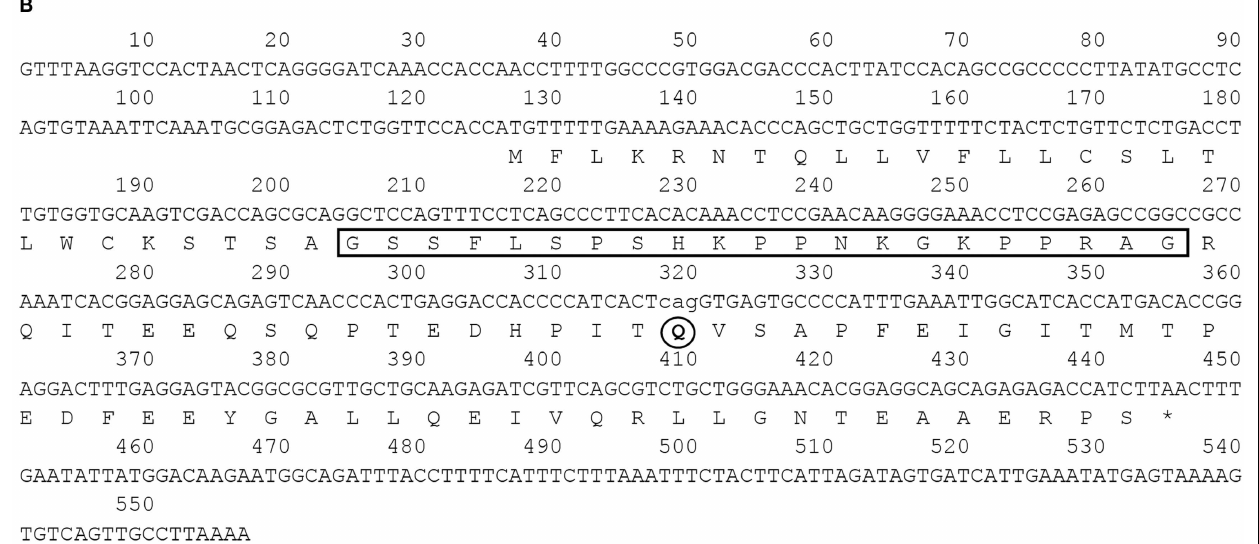
FIGURE 1 | Nucleotide and deduced amino acid sequences of barfin flounder ghrelins .The asterisk indicates the termination codon, the box indicates the sequence of the mature ghrelin, and the underlining indicates the polyadenylation signal (AATAAA). Four different cDNAs were obtained: (A)